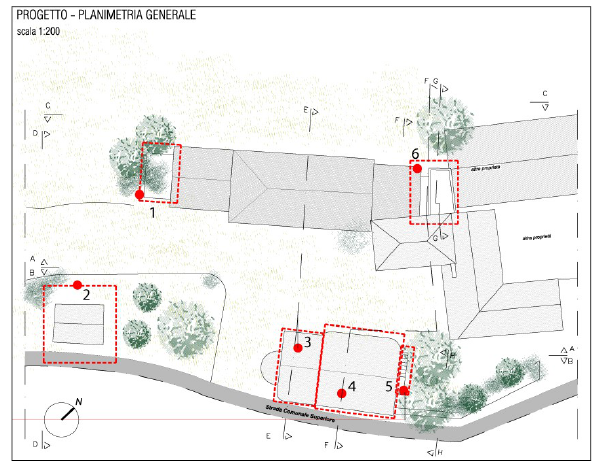
Figure 1. Areas of intervention in Cascina Crocetta.